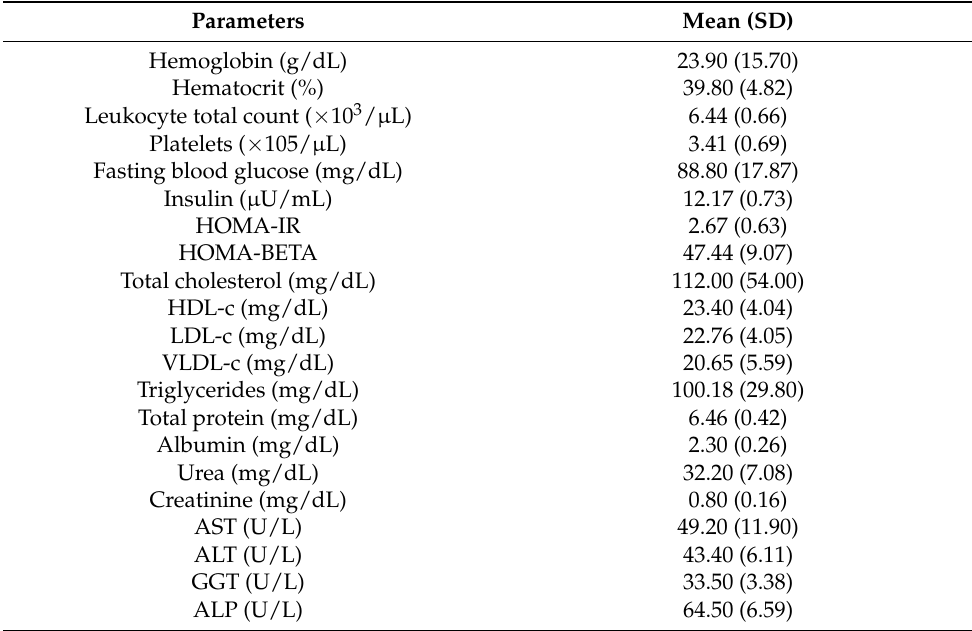
Table 2. Reference values of blood parameters in male, adult, eutrophic Wistar rats acclimated in the bioterium of UnP/Brazil in January